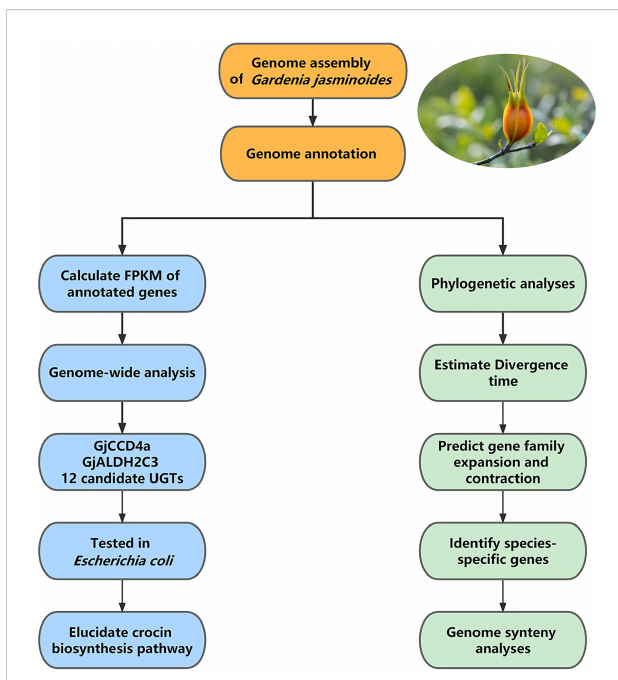
FIGURE 4 The work fl ow of data analysis of Gardenia jasminoides genome. The data analysis of the Gardenia jasminoides genome mainly includes genome annotation followed by comparative analysis and expression analysis of annotated